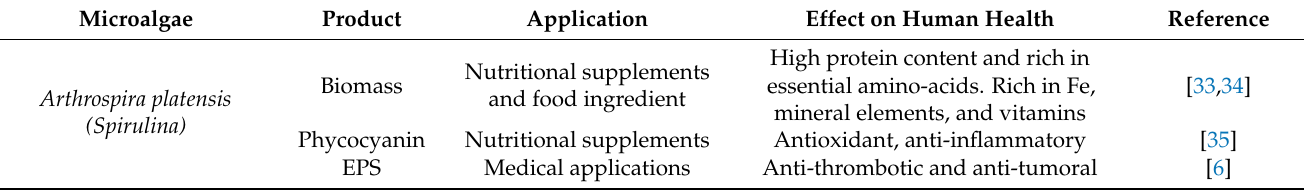
Table 1. Bioactive compounds from microalgae, their applications, and their potential health